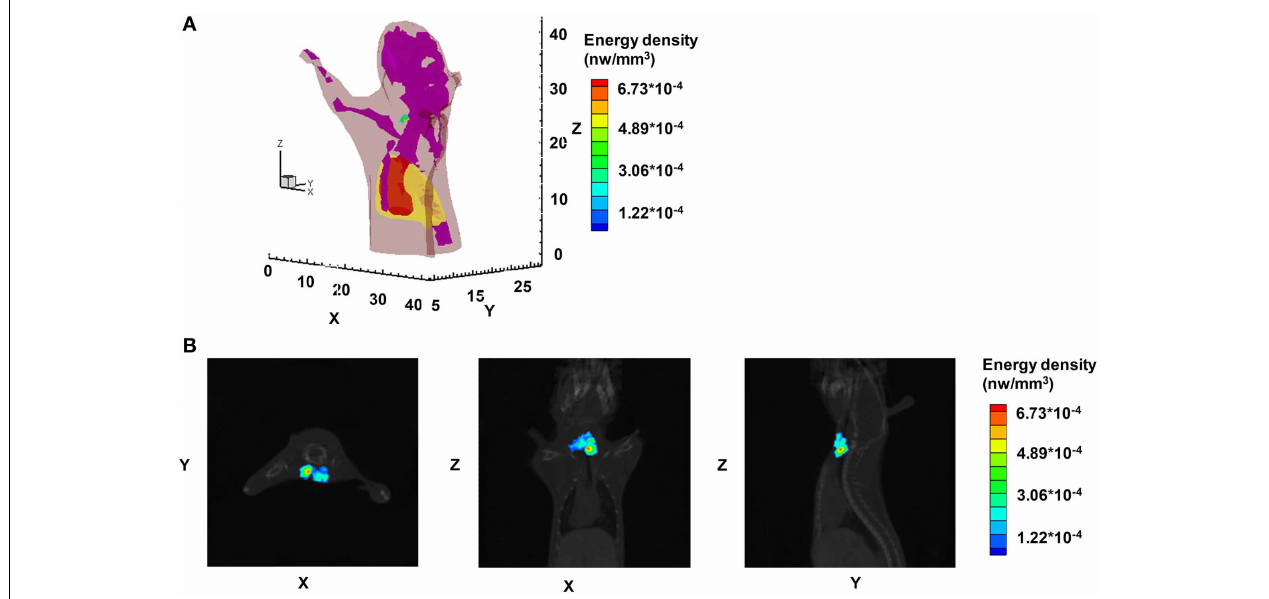
hybrid spectral CLT of Na 131 I uptake in the mouse thyroid in horizontal, coronal, and sagittal views respectively. (Adapted with the permission of Hu et al.